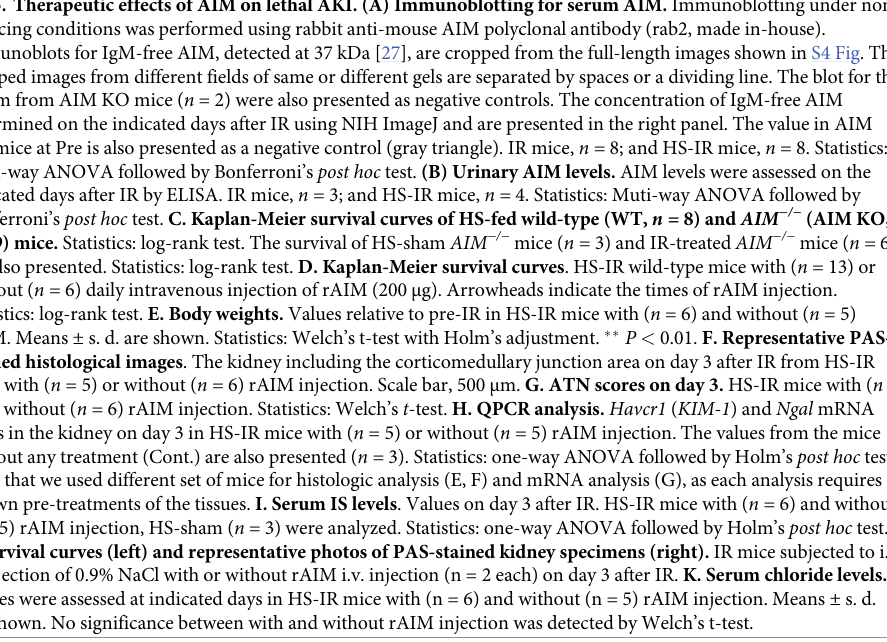
are shown. No significance between with and without rAIM injection was detected by Welch’s